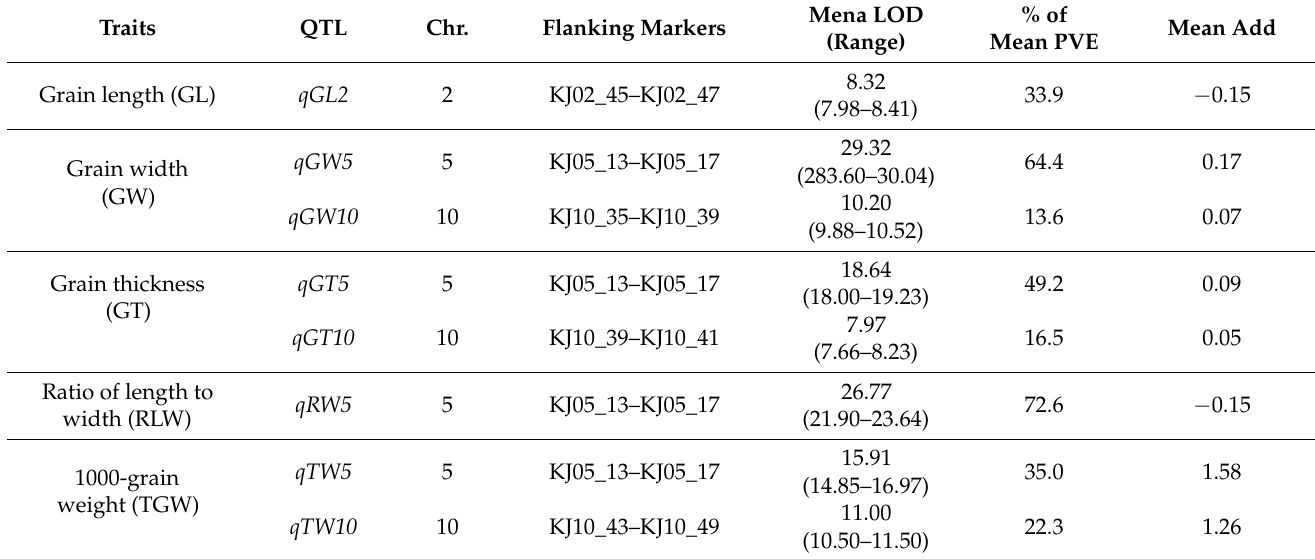
Table 2. QTL analysis of the traits related to grain shape during 2 years of RIL population.